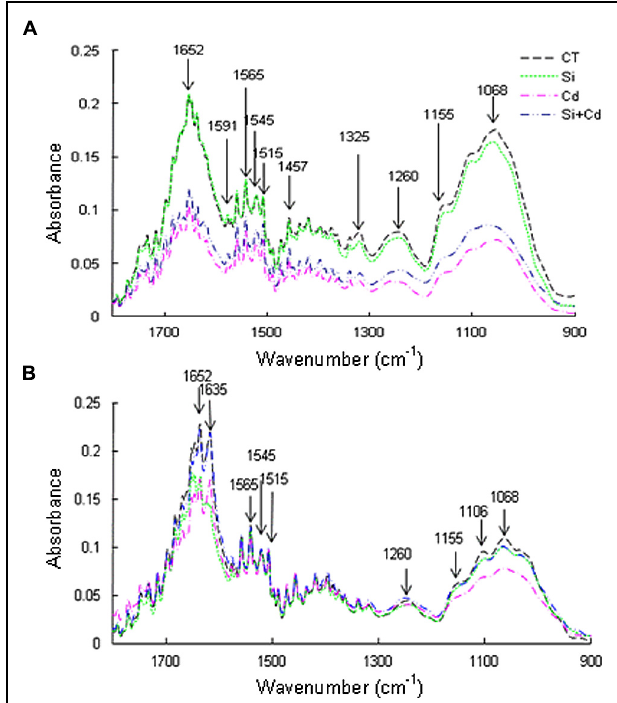
FIGURE 2 | Effects of Si on changes in fourier transform infrared spectra of root cell walls in tomato (A) and cucumber (B) under Cd stress.